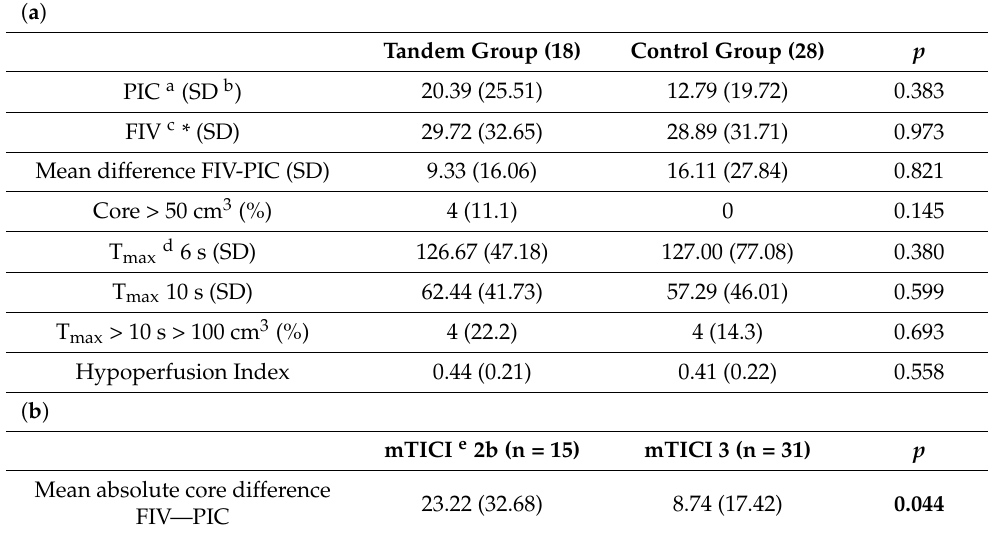
Table 4. Comparisons between groups for perfusion parameters—secondary analysis.